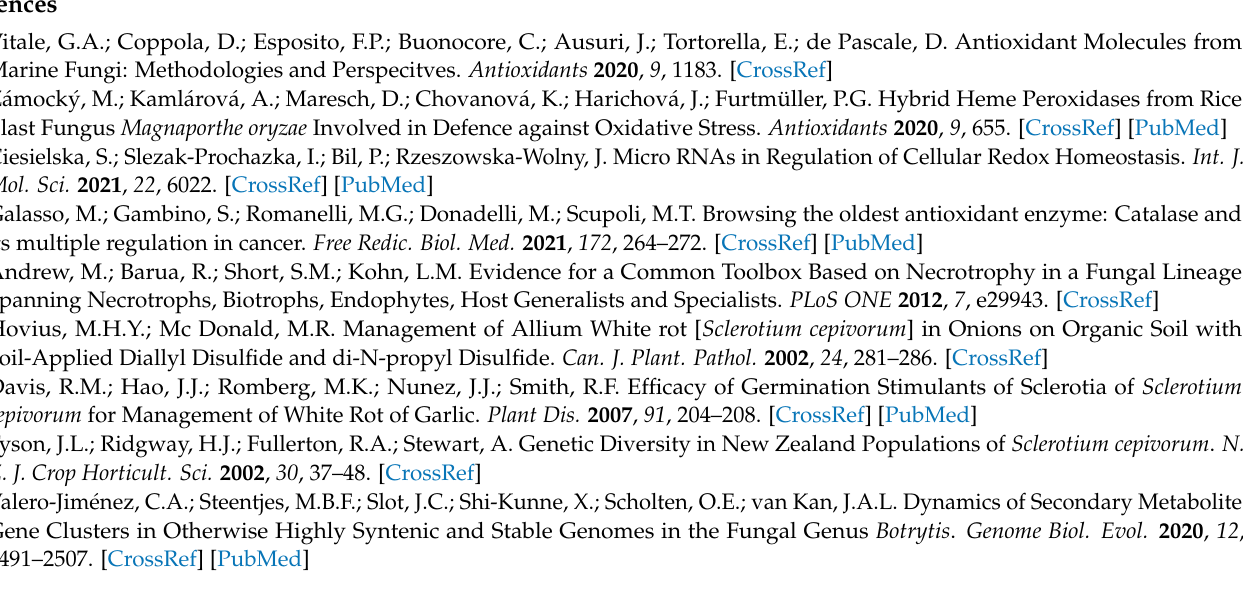
DNA fragments and cDNA fragments of ScepHyBpox1 (2 samples: induced with H 2 O 2 and non- induced); Figure S2: Annotated fragmentation spectra belonging to peptides from ScepHyBpox1; Figure S3: Multiple sequence alignment of selected Hybrid B heme peroxidases (complete in fasta format); Figure S4: Presentation of separated 3D models of ScepHyBpox1 and its six ancestors as obtained from AlphaFold; Table S1: DNA primers used for the amplification and sequencing of ScepHyBpox1 cDNA; Table S2: Overview of abbreviations used and accession numbers for aligned peroxidase sequences; Table S3: All detected extracellular proteins in the secretome of S. cepivorum ; Table S4: Identification details, quantification, and statistical analysis of ScepHyBpox1 in obtained secreted and cellular